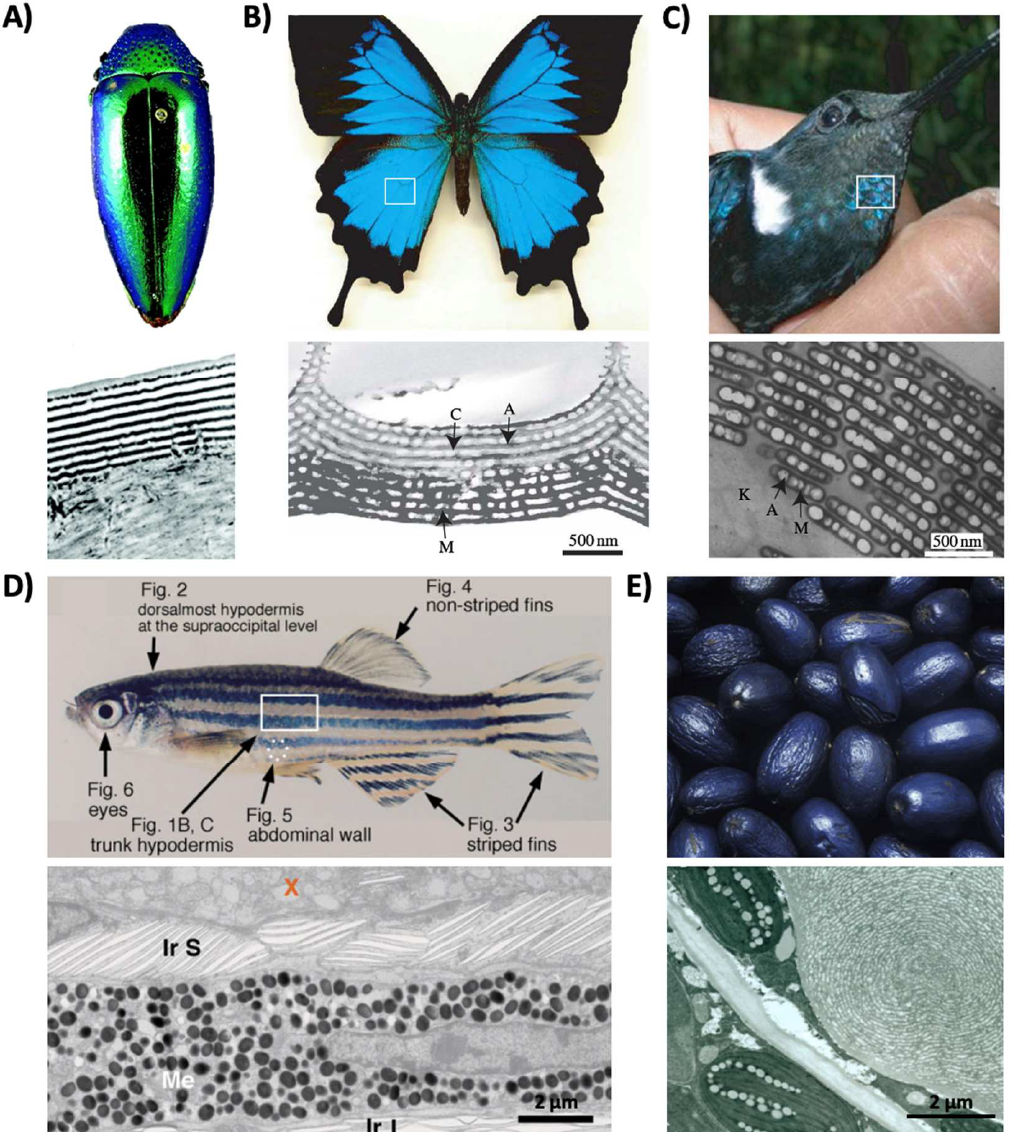
Figure 3. Structural color derived from 1D photonic crystal-like structures and iridophore cells. ( A ) ( Top ) An image of multilayer color in a buprestid or jewel beetle. ( Bottom ) An electron microscopy image of the cuticle of a Cicindela scutellaris beetle. ( B ) ( Top ) An image of a P. ulysses butterfly. (Bottom) A transmission electron microscopy image of the blue scale of the butterfly showing chitin (C) and air (A) arrays; the lower portion contains diffuse melanin (M). ( C ) ( Top ) An image of the C. prunellei hummingbird. ( Bottom ) A transmission microscopy image of a green barbule from a C. iris hummingbird, showing ordered layers of air (A) and melanin (M) in a keratin (K) matrix. ( D ) ( Top ) An image of a zebrafish. ( Bottom ) A transmission electron microscopy image of a portion of the zebrafish hypodermis showing xanthophores (X), type-S iridophores (Ir S), melanophores (Me), and type-L iridophores (Ir L). ( E ) ( Top ) An image of a D. michieana fruit. ( Bottom ) A transmission electron microscopy image of a transverse cross-section of a D. michieana fruit showing iridosomes. The images in part A are reproduced from [33]. The images in parts B and C are reproduced from [34]. The images in part D are reproduced from [35]. The images in part E are reproduced from [36].